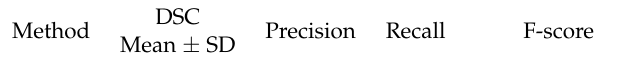
Table 1. Quantitative validation of segmentation results. Dice similarity coefficient (DSC), precision, and recall rates for the investigated segmentation methods when using enhanced ( USE ( x , y ) ) and B-mode US ( US ( x , y ) ) data as input to the segmentation